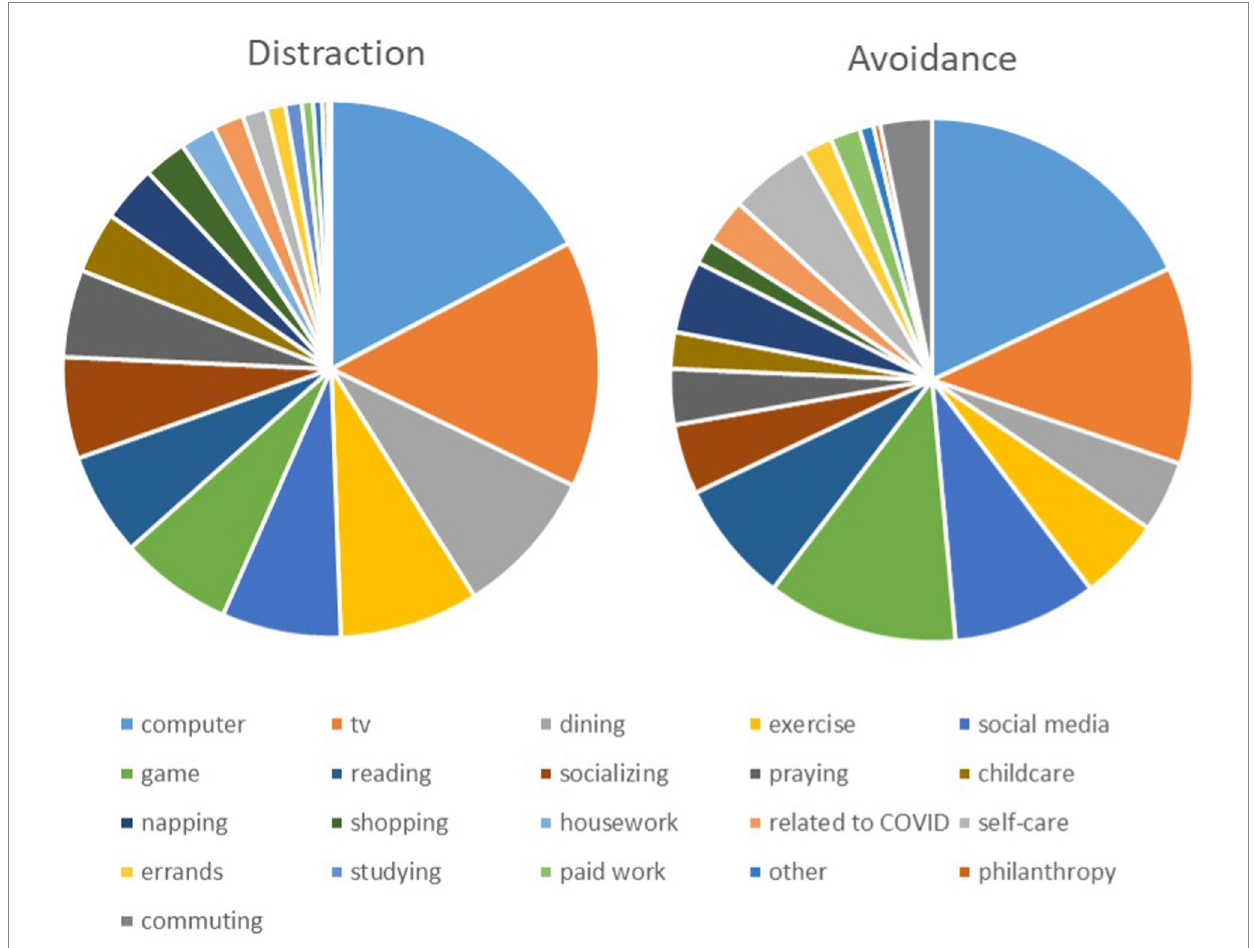
FIGURE 1 Relative frequencies of actives used for distraction and avoidance as reported in the daily